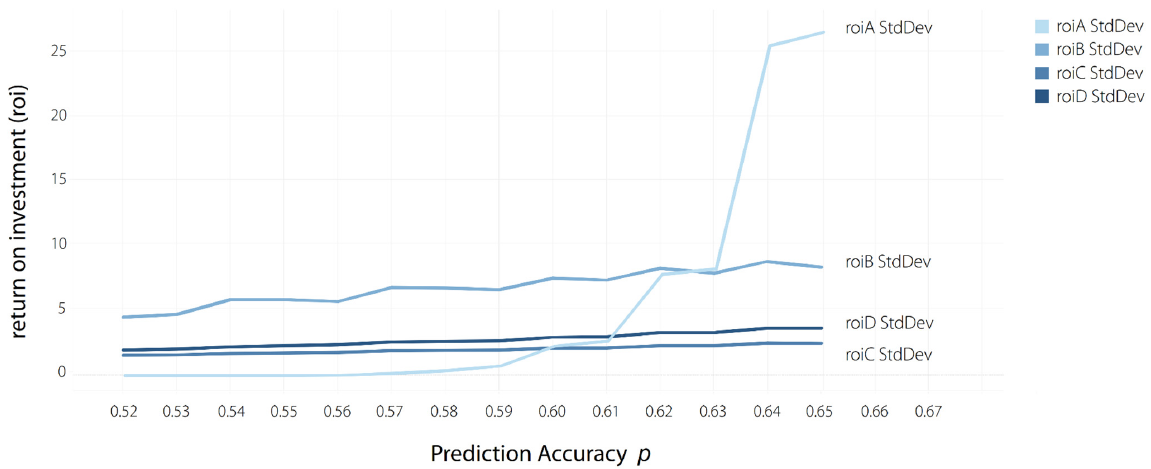
Figure 6. Change in (median) roi StdDev of the strategies in relation to prediction accuracy 𝑝 on the x ‐ axis.